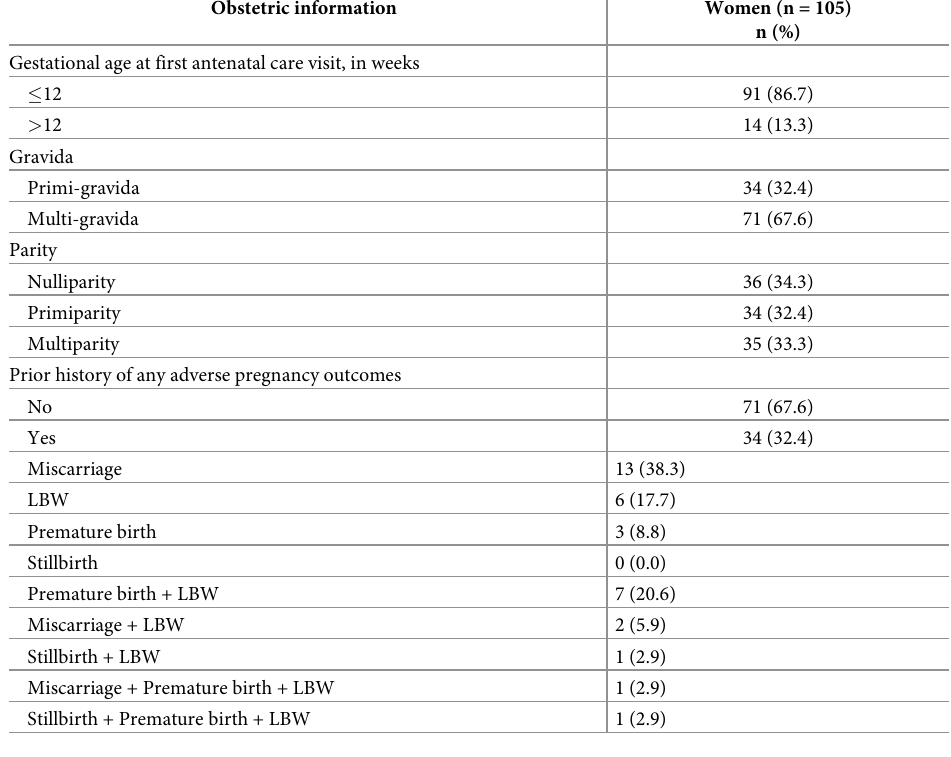
Table 2. Obstetric